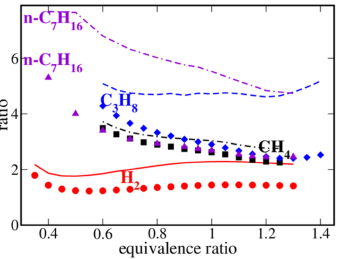
Figure 6. Dependencies of the ratios δ L / δ F r (lines) and δ L / δ T r (symbols) calculated for various fuels specified in